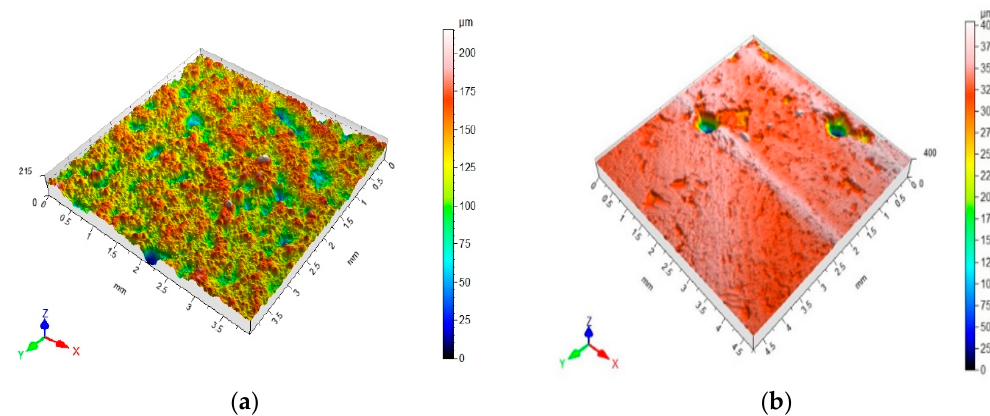
Figure 9. Microroughness values and representative profilograms showing the surfaces of mineral–asphalt mixtures (MAMs): ( a ) WC-1 (160 °C); ( b ) WC-2 (160 °C).